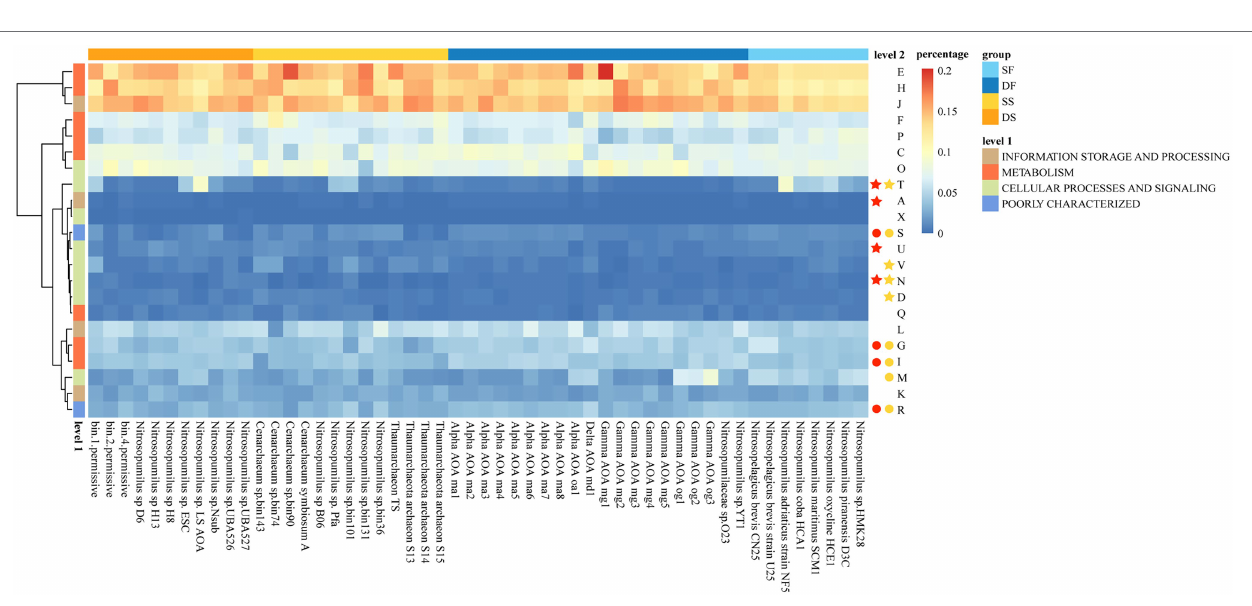
FIGURE 4 | The percentages of clusters of orthologous group (COG) functional categories for sponge-associated and free-living Thaumarchaeota. Colors on top indicate the source: SF, shallow water (light blue); DF, deep sea (dark blue); SS, shallow-water sponge (yellow); and DS, deep-sea sponge (orange). Colors on the left indicate level 1 COG categories. The colored stars/circles after the level 2 functional categories indicate the relatively enriched/deprived functions in all sponge- associated Thaumarchaeota (yellow star/circle) and deep-sea sponge-associated Thaumarchaeota (red star/circle) based on random forest